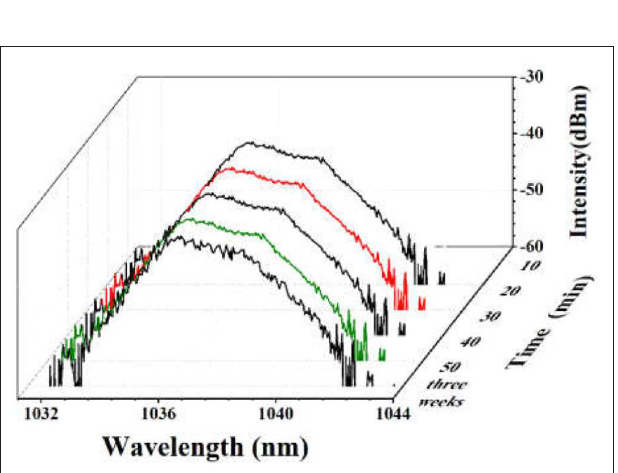
pulse with a full width at half maximum (FWHM) of 174 ps by Gaussian fitting. As shown in Figure 4D , the radio frequency (RF) spectrum shows a distinct peak at 14.7 MHz, which matches the repetition rate of the mode-locked fiber laser. The signal-to-noise ratio (SNR) of the RF spectrum is 59.8 dB, indicating that the output mode-locked pulse has excellent